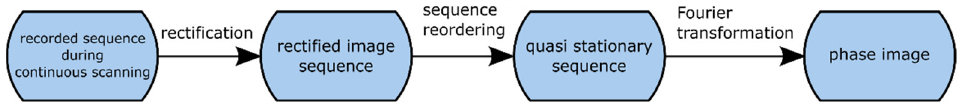
Figure 10. Postprocessing of measurements in continuous motion.